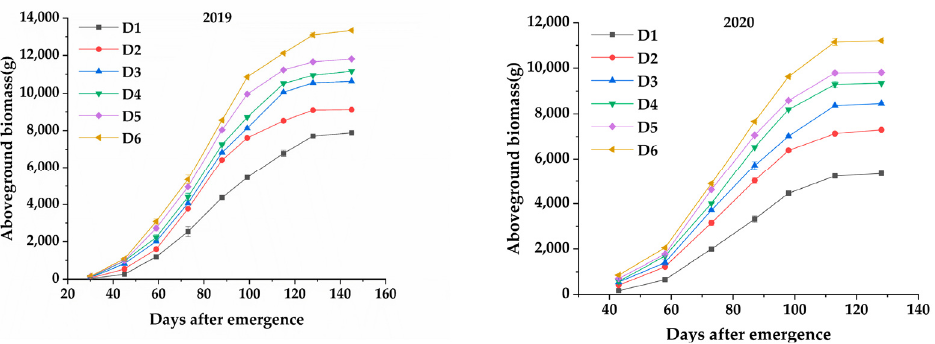
Figure 5. The aboveground biomass of cotton grown at different planting densities in 2019 and 2020. With the advancement of the growth process, the population biomass of cotton under different densities showed an upward trend (Figure 5), and there were significant differences among different densities with the following order: D6 > D5 > D4 > D3 > D2 > D1. The maximum standard error of the population biomass among different density treatments was 268.58 g in 2019 and 168.94 g in 2020. The highest biomass under D6 was 13,340.55 g at 145 DAE in 2019 and 11,209.47 g at 128 DAE in 2020. The highest biomass under D1 was 7884.86 g at 145 DAE in 2019 and 5340.10 g in 2020. The dry matter accumulation under the different densities conformed to the logistic curve in two years. The fitting equation (Supplementary Materials Table S3) was based on Formula (4) and derived from Formula (4). The average growth rate and maximum growth rate under the different densities was calculated, as shown in Table 3. The start time, end time, and occurrence time of the fastest growth period are shown in Supplementary Materials Table S2. Table 3. Characteristic values of biomass accumulation in the cotton growing season in 2019 and 2020.